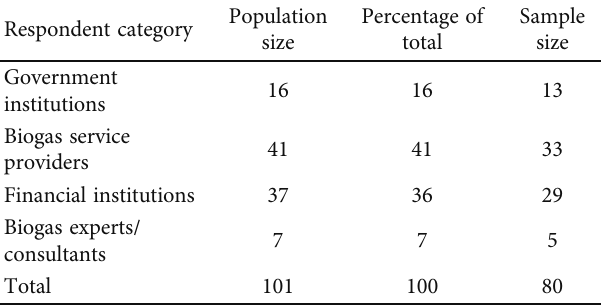
Table 1: Respondent status and sample size